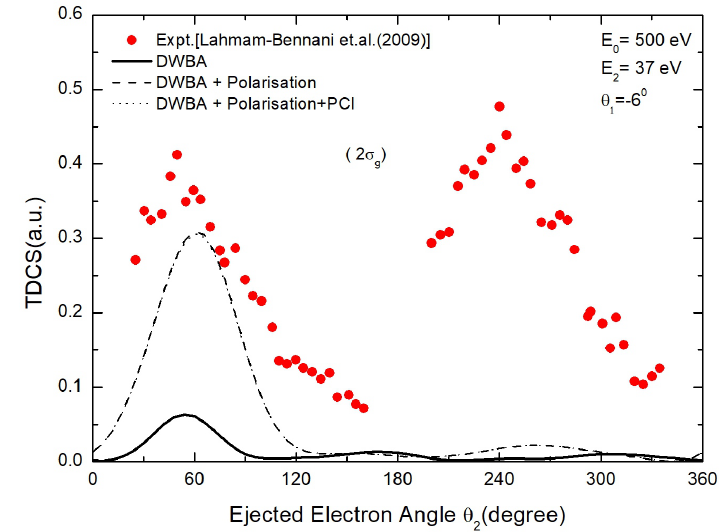
Figure 7. TDCS calculation for the ionization of the inner orbital 2 σ g of N 2 . The ejected electron energy chosen here is 37 eV. The legends and kinematics are displayed in the Figure frame.